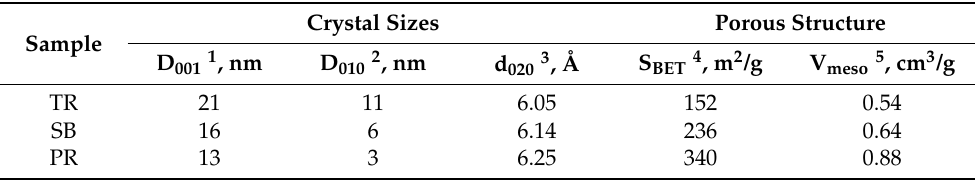
Table 3. Crystal sizes and porous structure of boehmites.